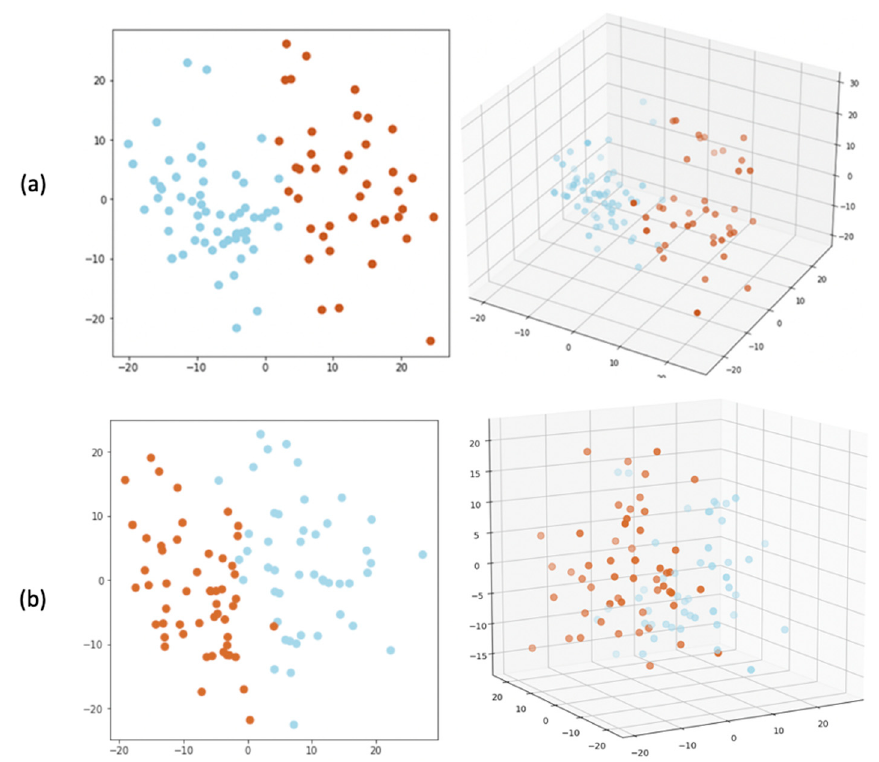
Figure 15. Unsupervised clustering visualization using K-means clustering algorithm, ( a ) session number 3 and ( b ) session number 5 of all users.